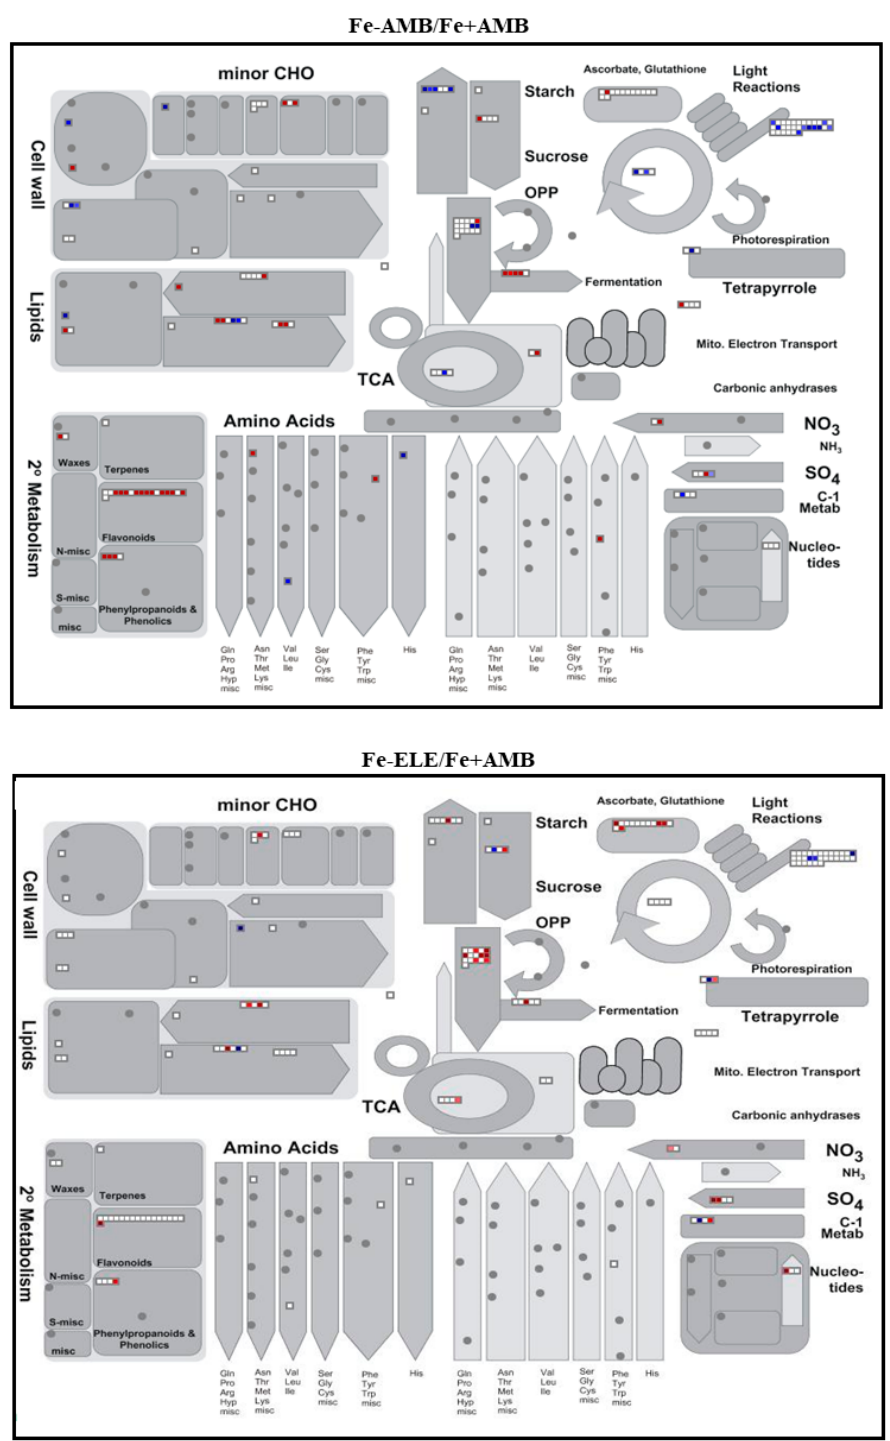
Figure 5. MapMan metabolism overview maps showing changes in DEPs in leaf tissues under eCO 2 and Fe-limitation. Fe+AMB, Fe-sufficient + aCO 2 ; Fe+ELE, Fe-sufficient + eCO 2 ; Fe-AMB, Fe-limitation + aCO 2 ; Fe-ELE, Fe-limitation + eCO 2 . Squares represent log2 expression values, and genes in red are upregulated, and those in blue are repressed.